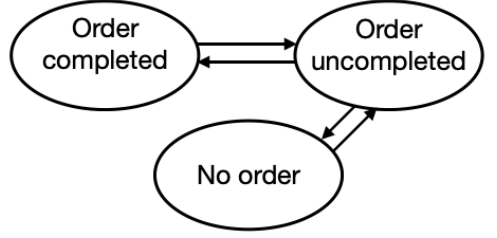
Figure 3. Sequence of possible